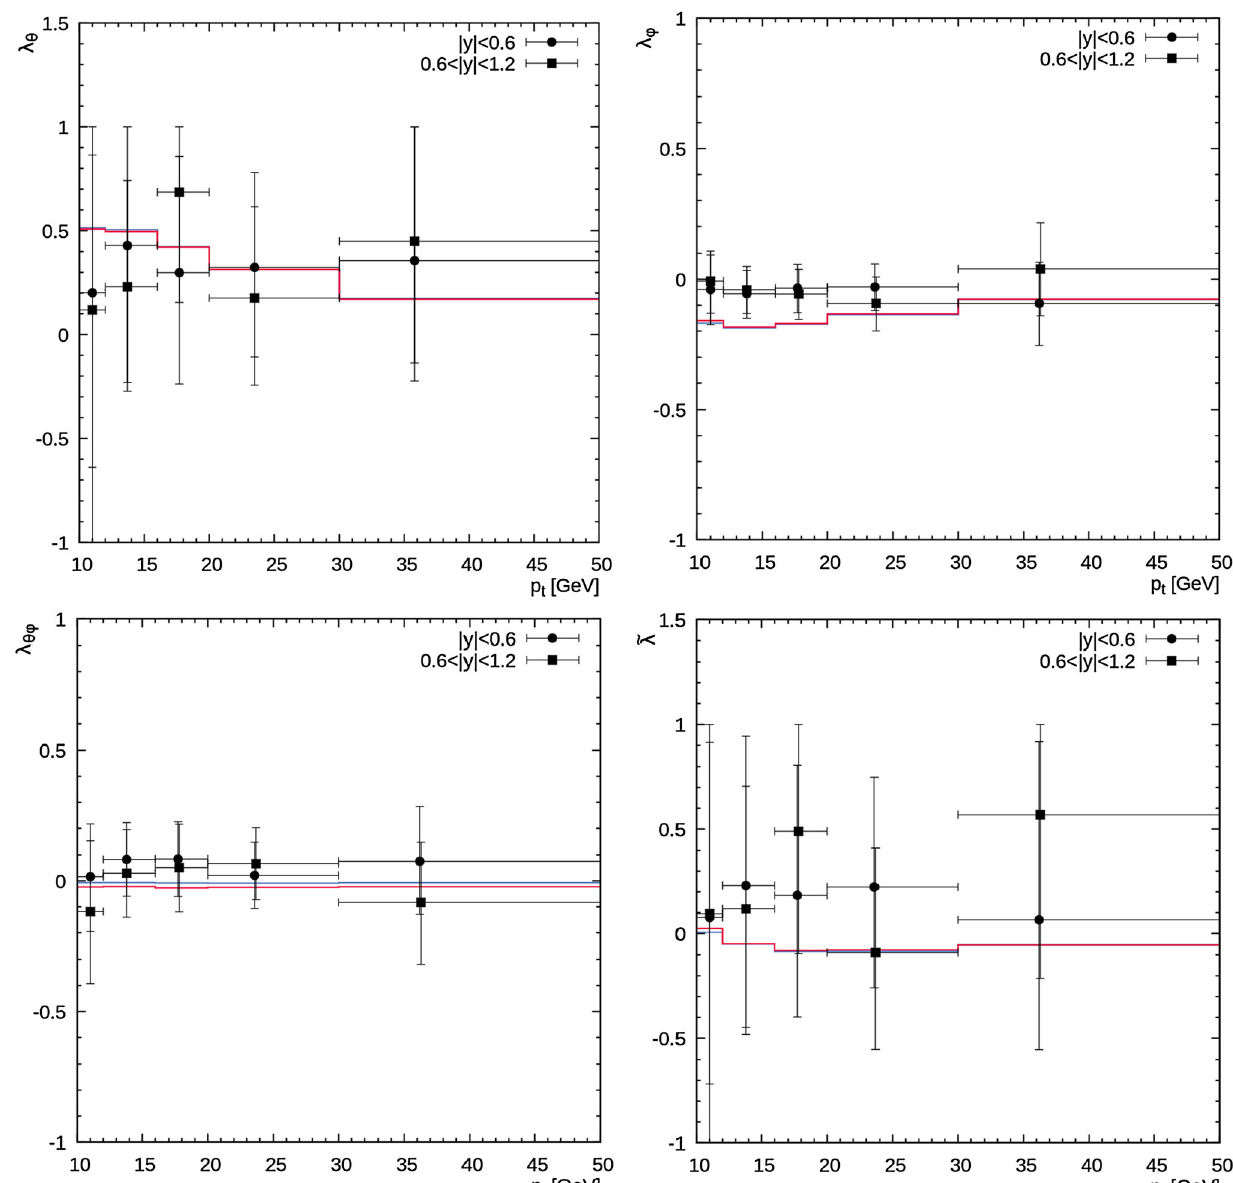
Fig. 9 The polarization parameters λ θ , λ φ , λ θφ and ˜ λ of ϒ( 3 S ) mesons calculated in the perpendicular helicity frame as function of its transverse √ s = 7 TeV. Notation of all histograms is the same as in Fig. 7. The experimental data are from CMS momentum at